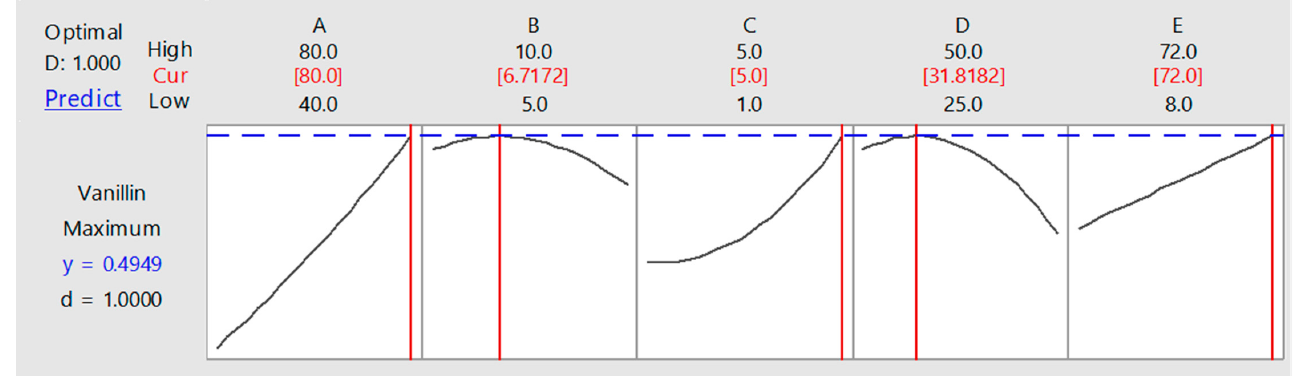
Figure 4. Desirability chart for biovanillin production using sugarcane bagasse via solid-state fermentation.